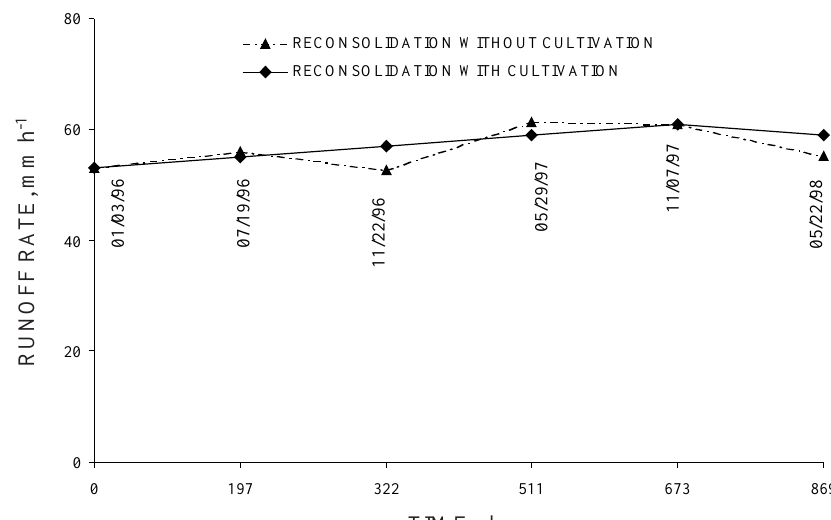
Figure 4. Steady-runoff rate as a function of time in the reconsolidating soil